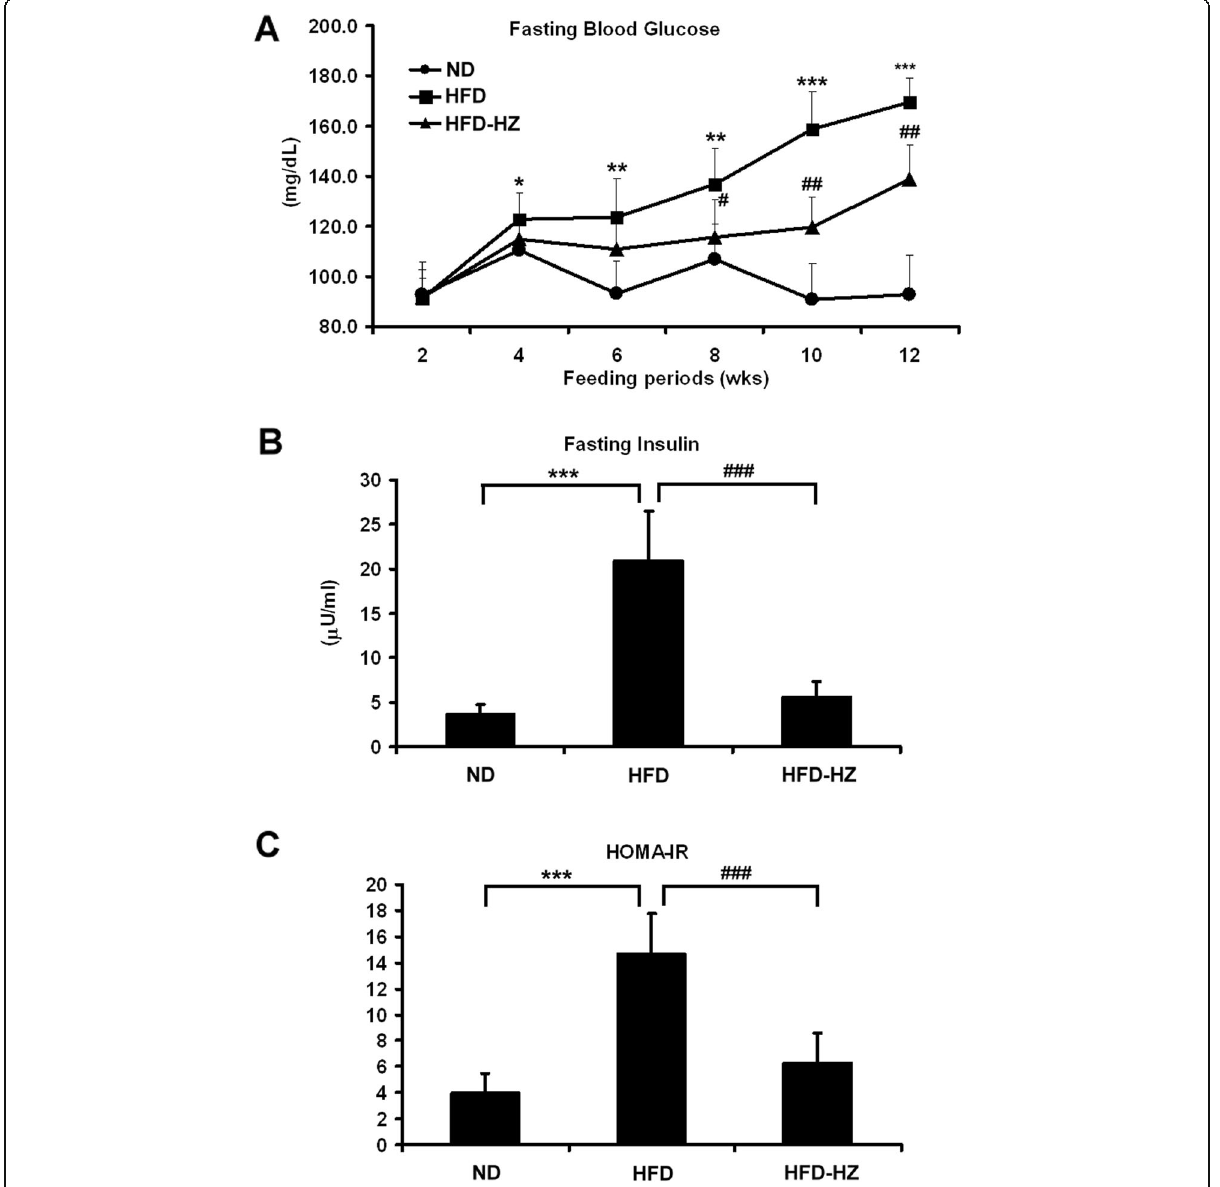
Fig. 7 The effect of HZ extract treatment on blood glucose and insulin resistance in HFD-fed C57BL/6J mice. a Levels of blood glucose after 12 h of fasting. b Levels of plasma insulin after 12 h of fasting. c The HOMA-IR index calculated using fasting blood glucose and insulin levels. Data are shown as means ± SEM (n = 10 per group). ND vs. HFD: * p < 0.05; ** p < 0.01; *** p < 0.001. HFD vs. HZ: # p < 0.05; ## p < 0.01; ### p <